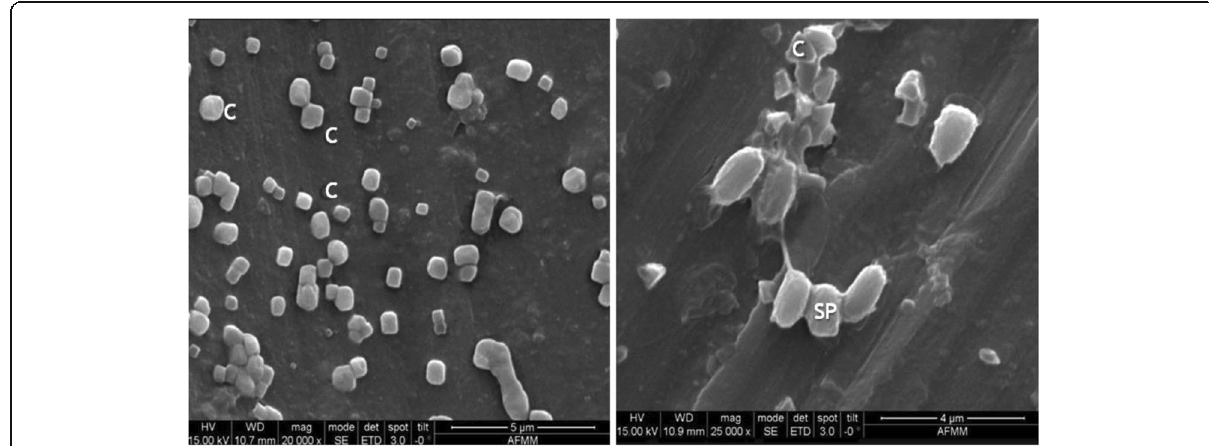
Fig. 3 Scanning electron micrographs of Bacillus thuringiensis spores and crystals (20000 x). C-Cuboidal; Sp- Spore; C-Amorphous